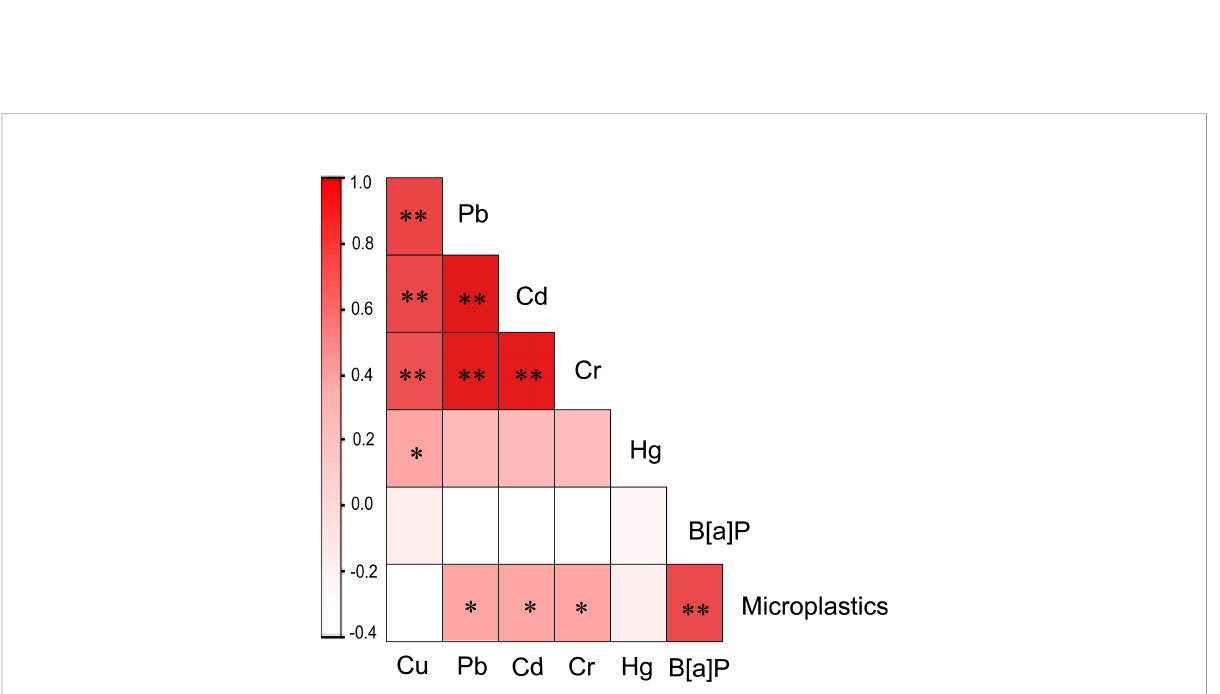
FIGURE 7 Pearson correlation analysis results of the different pollutant types accumulated in seahorses. The colors indicate the correlation values (r). The asterisks represent a signi fi cant correlation at the 0.05 level (*) and 0.01 level (**),